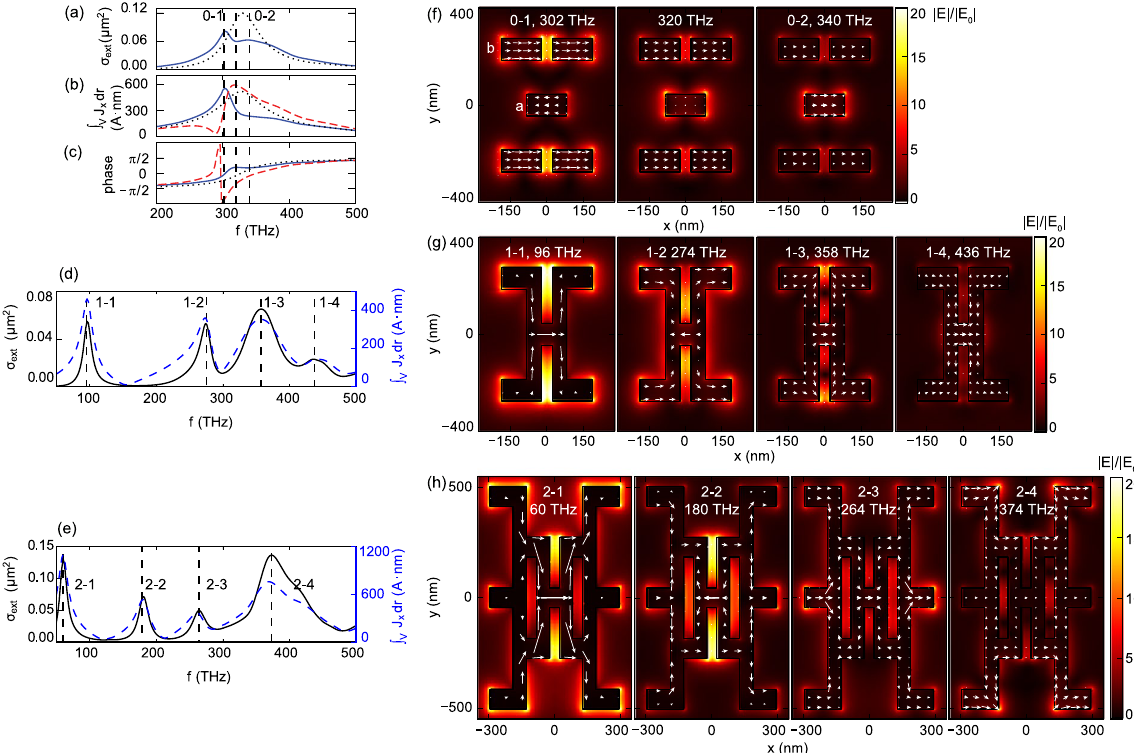
Figure 3. ( a ) Simulated extinction cross section of the pentamer (blue line) compared with that of a single rod multiplied by 5 (black dots). ( b ) Simulated amplitude and ( c ) phase of net current in the x -direction in a (blue line) and b (red dashed line) compared with the current in a single rod (black dots). ( d , e ) Simulated extinction coefficient (black line) and amplitude of net current in the x -direction (blue dashed line) of ( d ) the first and ( e ) the second generations of dendritic antennas. ( f – h ) Simulated maps of electrical field and current distribution in a cross section of ( f ) the pentamer, ( g ) the first and ( h ) the second generations of the dendritic antennas at resonant frequencies specified by the black dashed lines in ( a – e